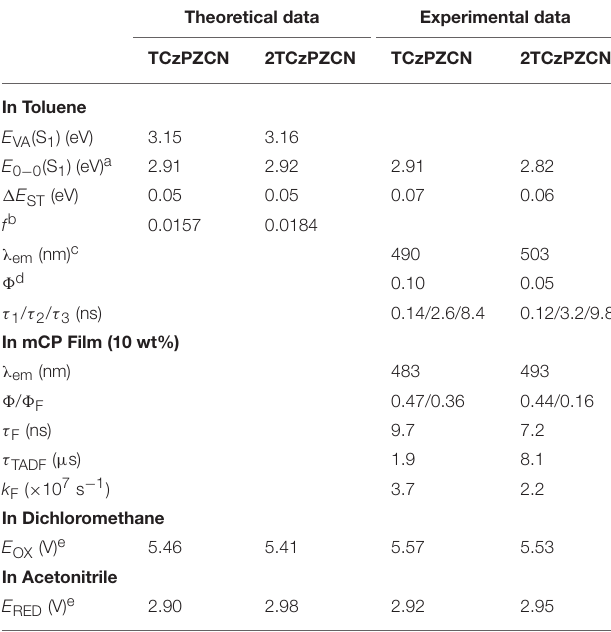
TABLE 2 | A comparison of theoretical predictions and experimental data on photophysical and electrochemistry of the investigated molecules. Theoretical